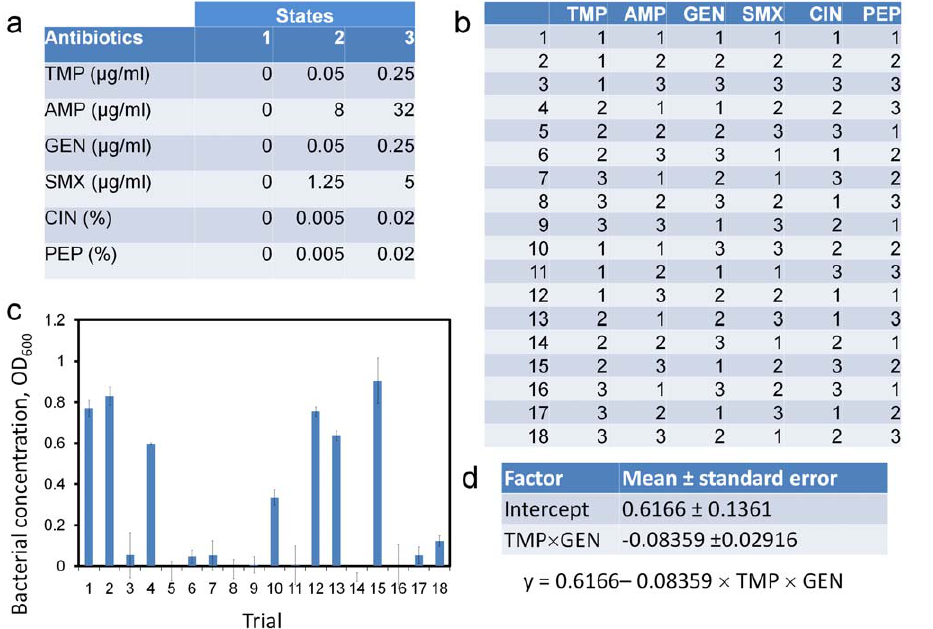
Figure 4. A 6-drug screening experiment. (a) Three concentration levels are assigned for each antibiotic. (b) The 18 experimental trials defined by the fractional factorial design. (c) Experimental results of bacterial growth under different situations. (d) Result of the regression analysis in the MACO scheme.